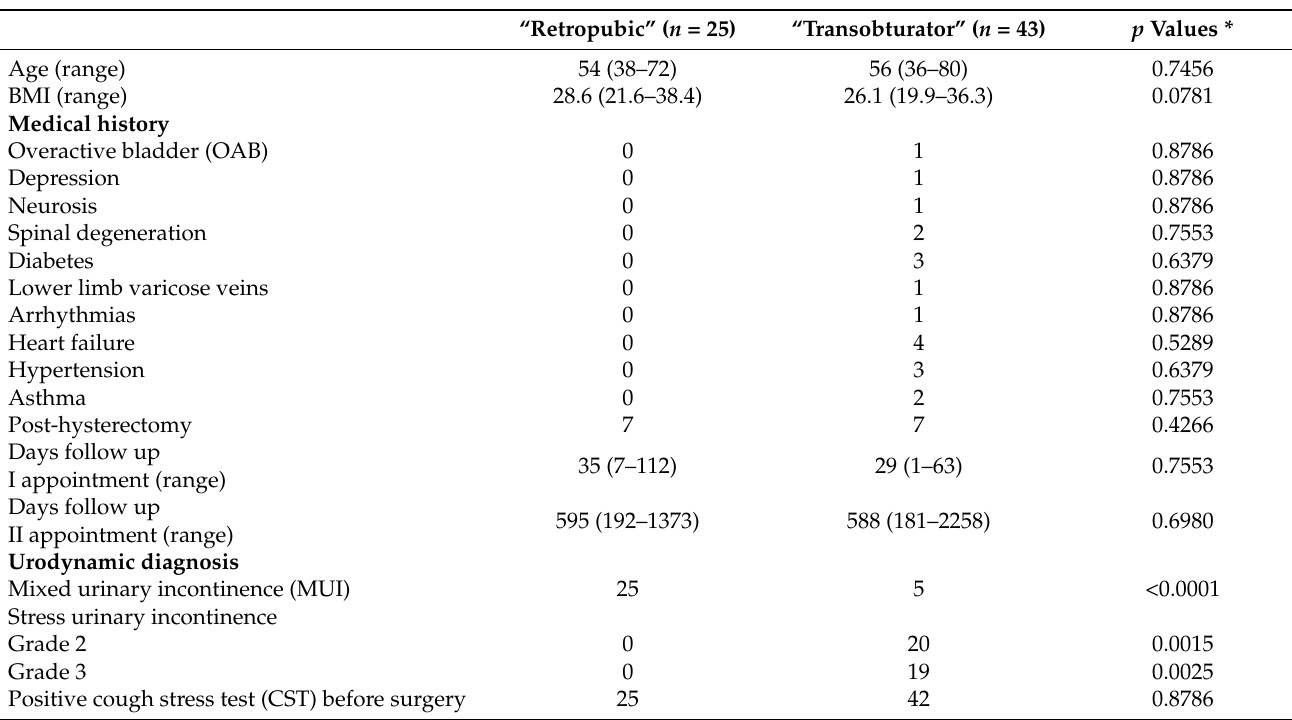
Table 1. Demographic, preoperative and urodynamic